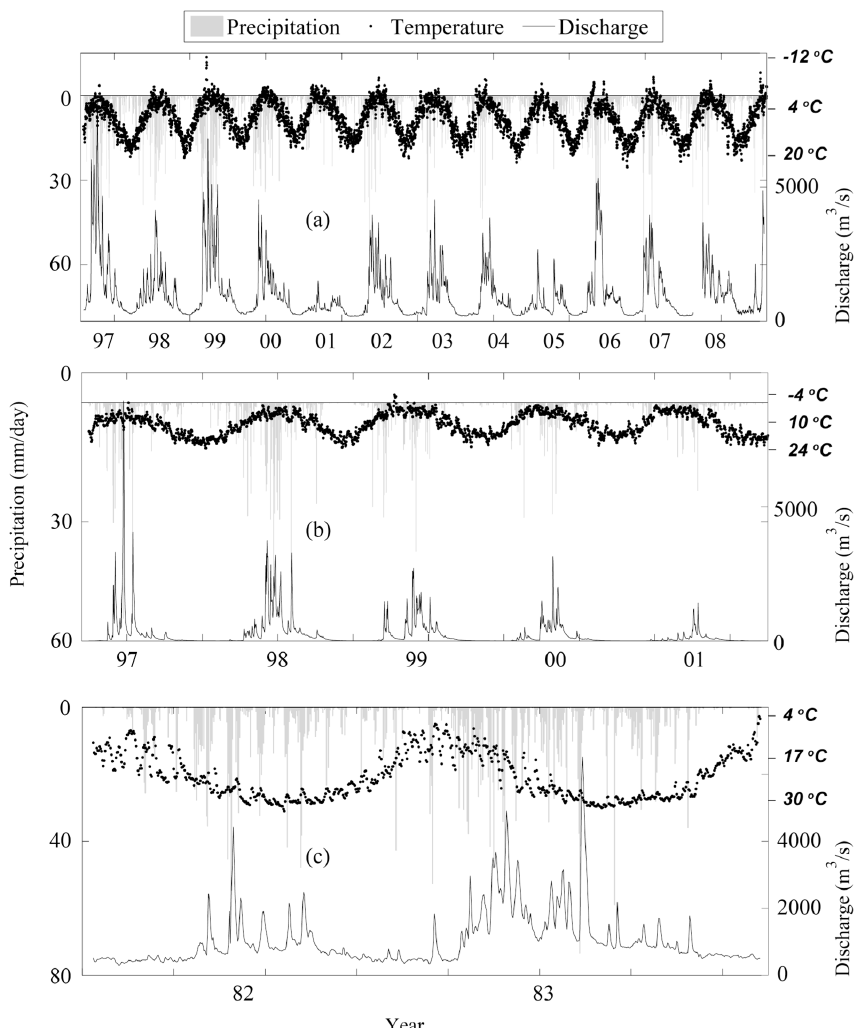
Fig. 4. Observed daily average temperature ( ◦ C), precipitation (mm), and discharge (m 3 s − 1 ) for (a) Willamette River basin, (b) Eel River basin, and (c) Dongjiang River basin. The y-axes ticks for daily average temperature show minimum, mean, and maximum values.